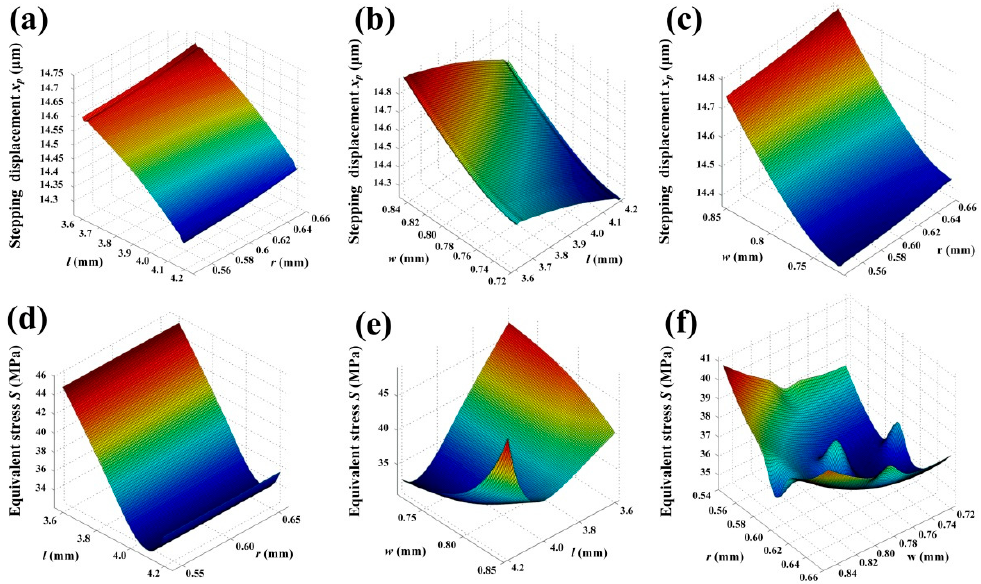
Figure 6. Stepping displacement x p plot in terms of ( a ) l and r , ( b ) w and l ; ( c ) r and w ; the maximum equivalent stress S plot in terms of ( d ) l and r ; ( e ) w and l ; and ( f ) r and w .